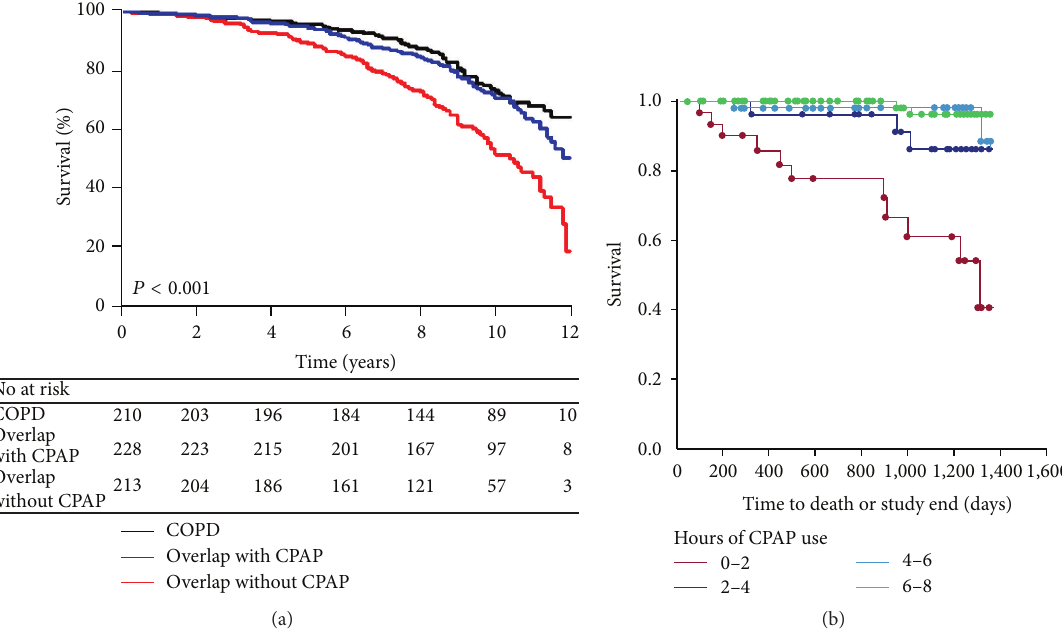
Figure 1: (a) Kaplan-Meier survival curves for survival among COPD patients, overlap syndrome patients without CPAP treatment, and overlap syndrome patients on CPAP treatment. This study included only severe OSA patients (AHI > 30), and CPAP was not randomly assigned (from [3], permission granted); (b) Kaplan-Meier survival curves for survival among patients with COPD and OSA overlap syndrome, stratified by CPAP use per night (from [22], permission